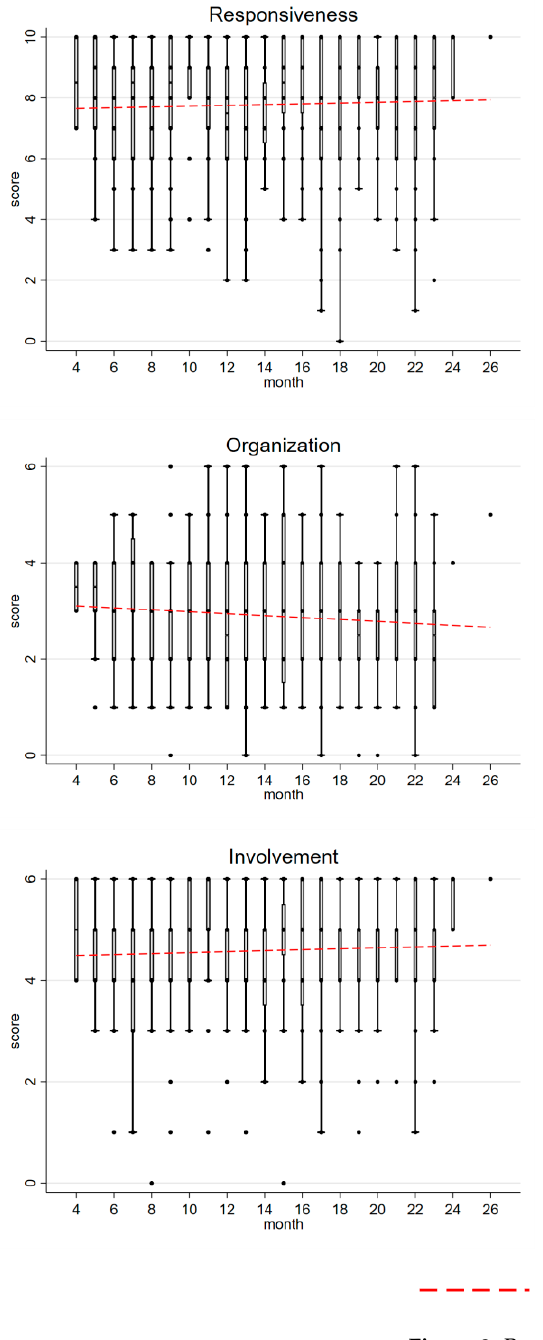
Figure 3. Boxplots for HOME scores by age.